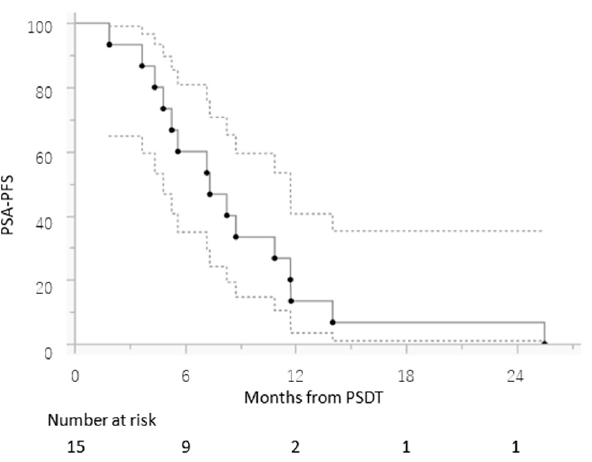
Figure 1. PSA progression-free survival (PSA-PFS) for patients with oligometastatic castration-resistant prostate cancer treated with progressive site-directed therapy (PSDT). The 95% intervals calculated for each time point are shown as dashed lines.